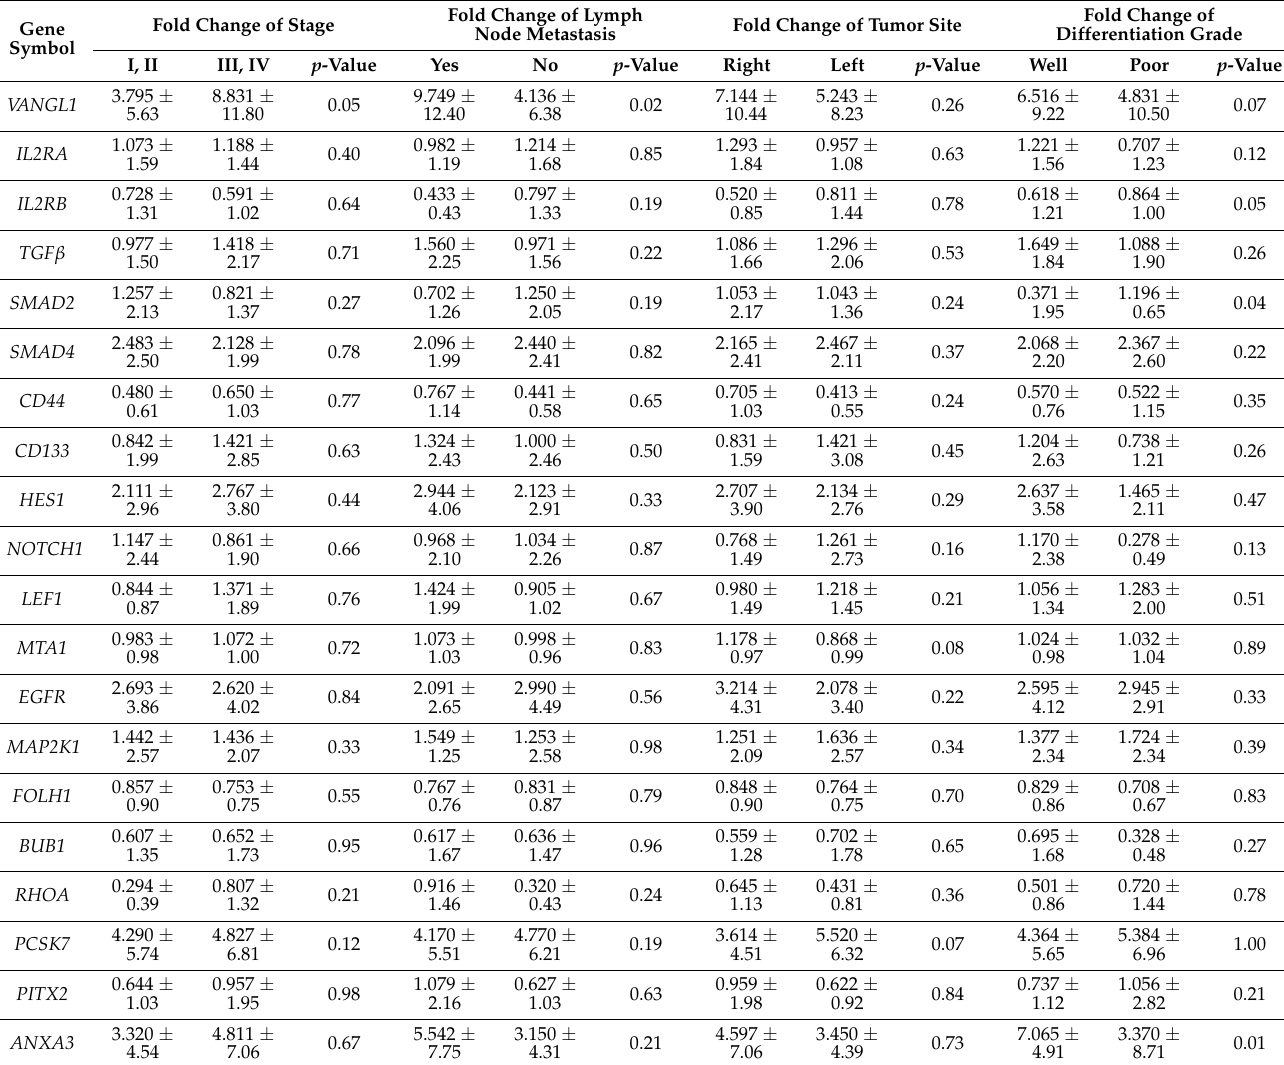
Table 4. Relationships between the expression of 20 CRC study genes and clinical and pathological characteristics of